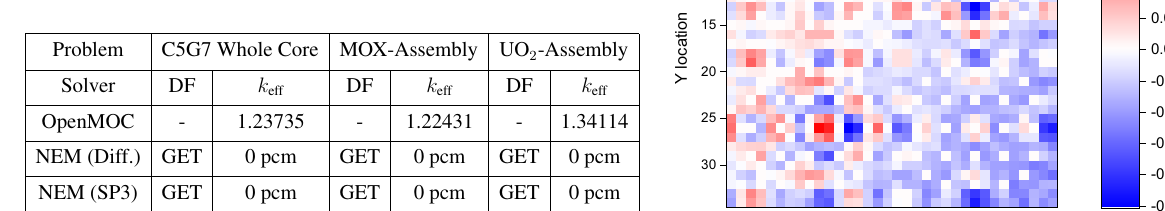
Table 2: Equivalence Calculations for Assemblies and C5G7